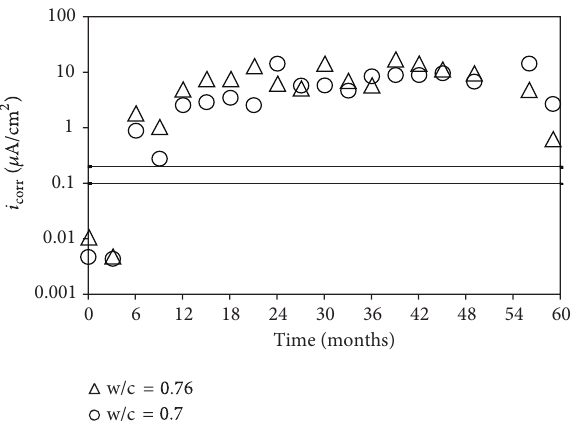
F 5: Instantaneous corrosion rate of the rebar (w/c = 0.70 and 0.76, 3 days of curing,